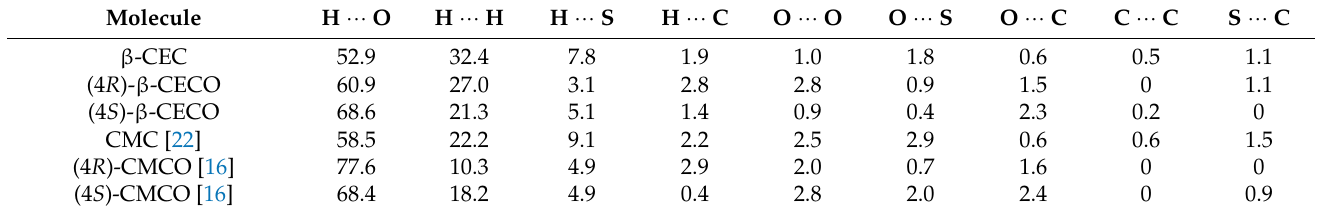
Table 1. Contributions (%) of the intermolecular contacts to the Hirshfeld surfaces [26] of S -(2- carboxyethyl)- L -cysteine, its sulfoxides, and structurally related molecules.